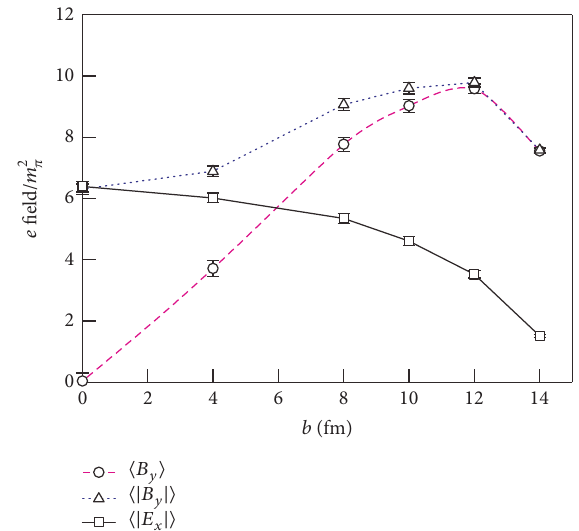
Figure 15: Impact parameter dependence of event averaged mag- netic and electric fields at the centre of the fireball for Au-Au = 200 GeV. Figure is from collisions at √𝑠 NN = 200 GeV for 𝑏 = 12 fm. NN